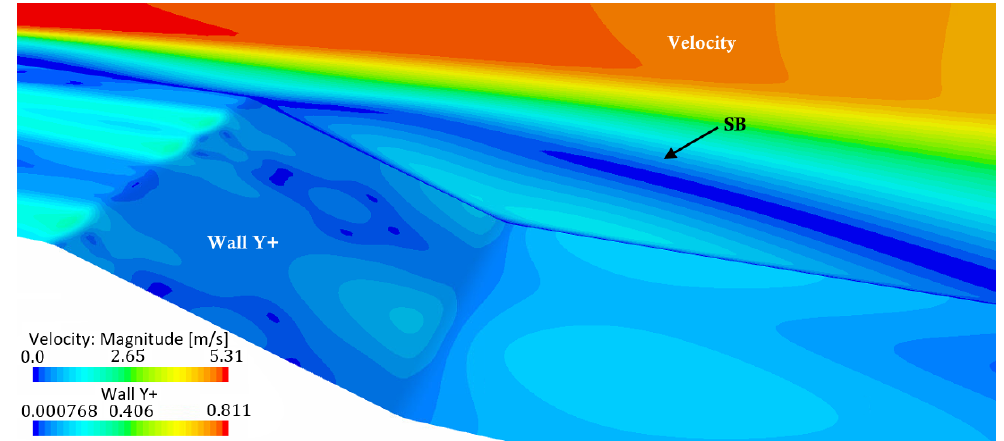
Figure 15. Simulated flow separation affected by the knitted wire mesh with two rows. The velocity is shown on the symmetry plane S of a stitch. On the bottom channel walls, the y + value is presented. SB denotes a separation bubble.